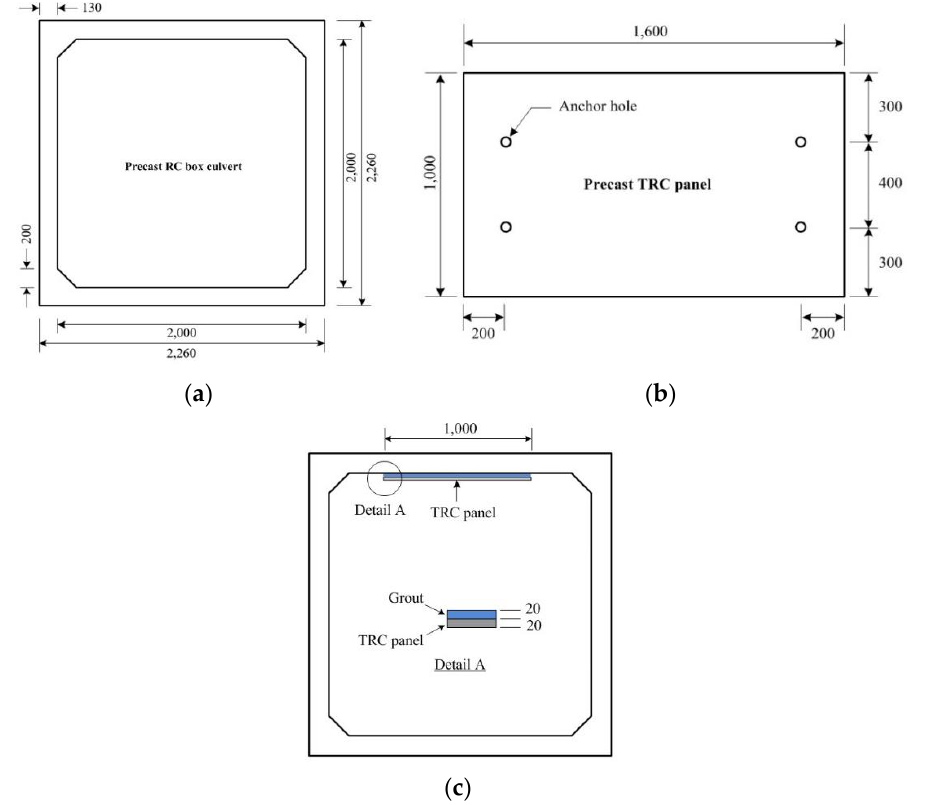
Figure 14. Strengthening plan for a deteriorated RC box culvert: ( a ) dimensions of RC box; ( b ) dimensions of precast TRC panel; ( c ) strengthening plan.